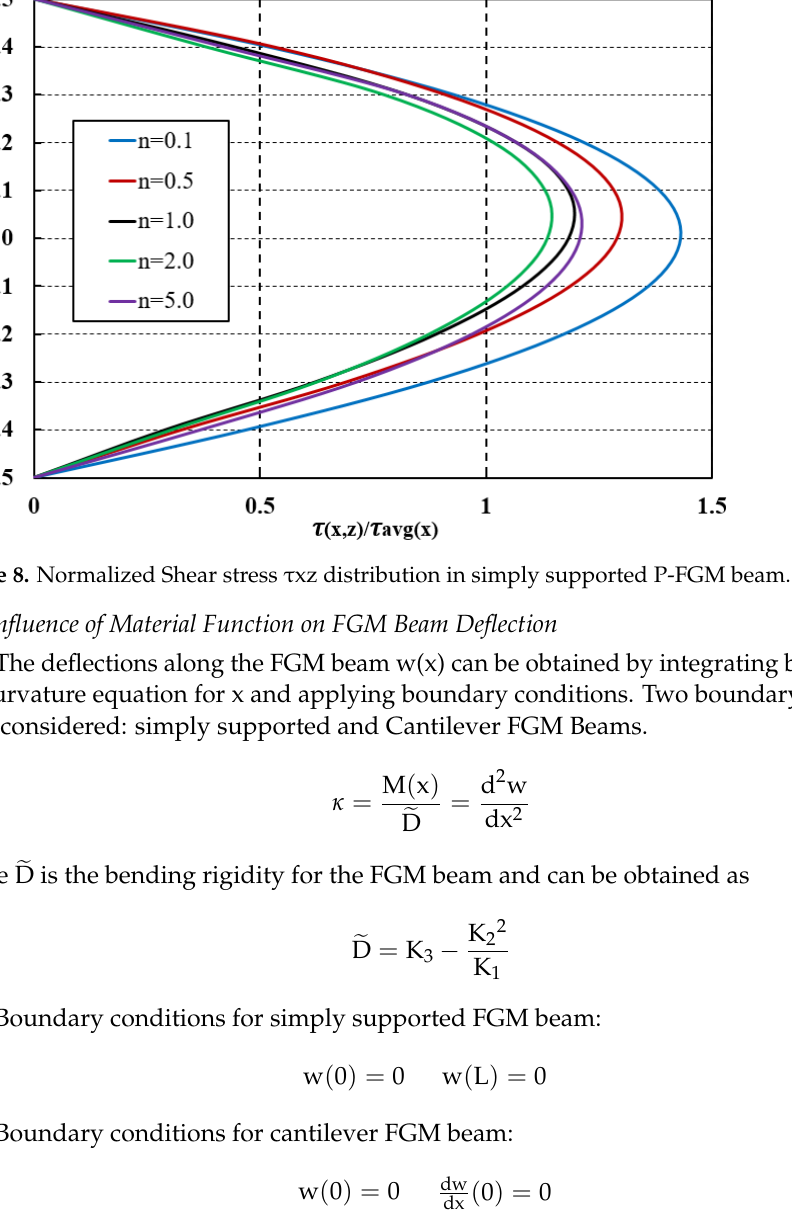
Figure 7. Normalized Axial stress σ xx distribution in simply supported P-FGM beam.